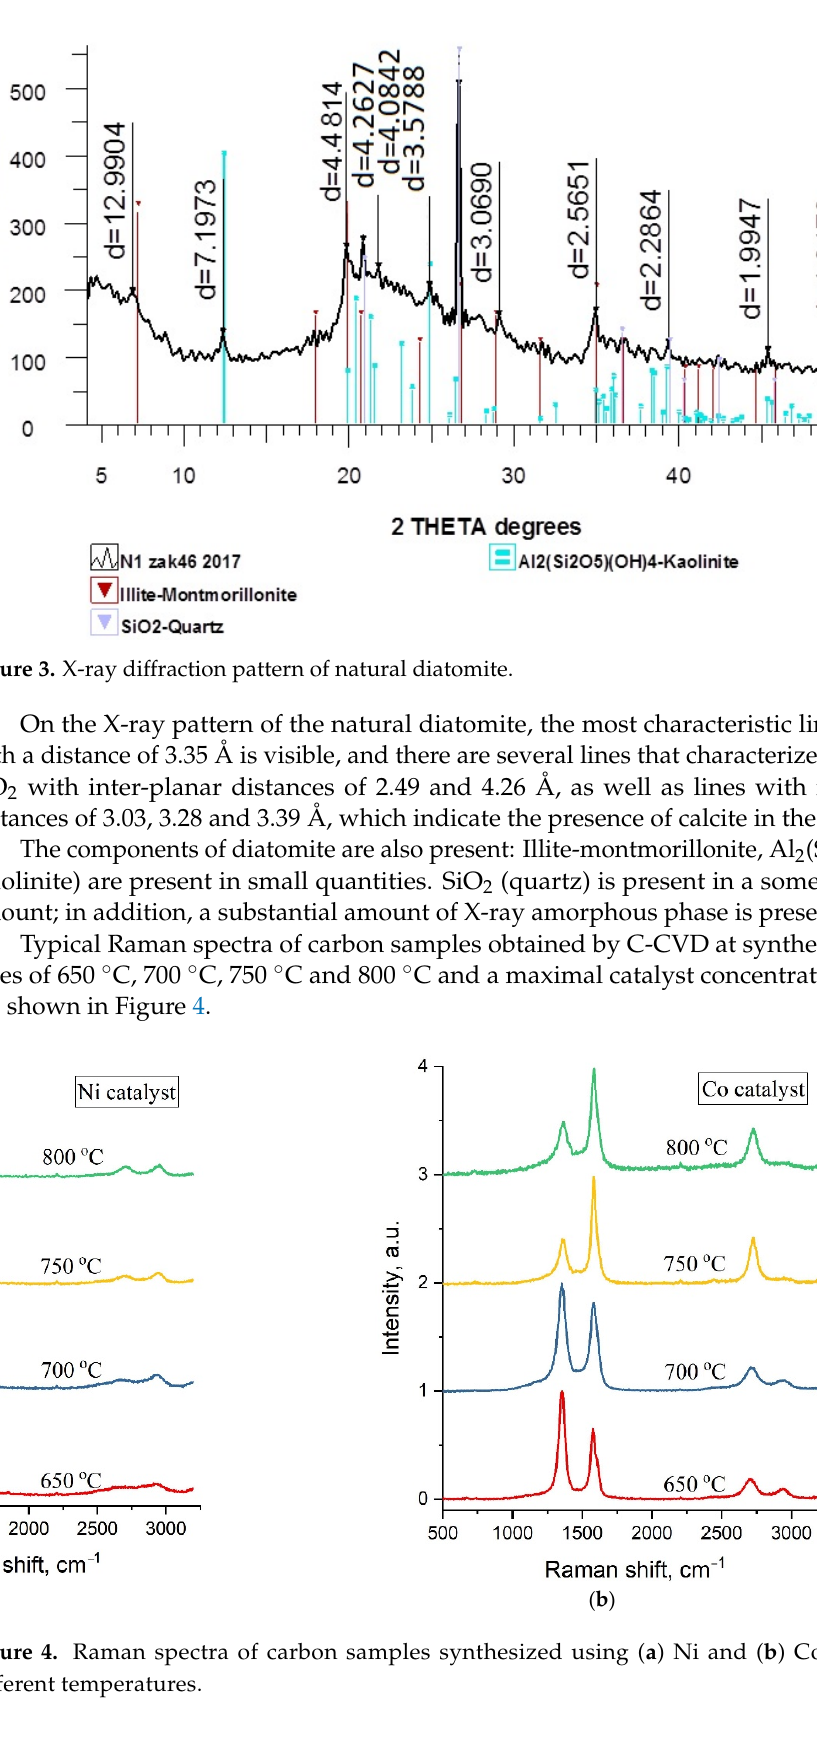
( b ) Figure 5. Dependence of the FWHM of the D peak on the synthesis temperature. ( a ) Ni and ( b ) Co catalysts.